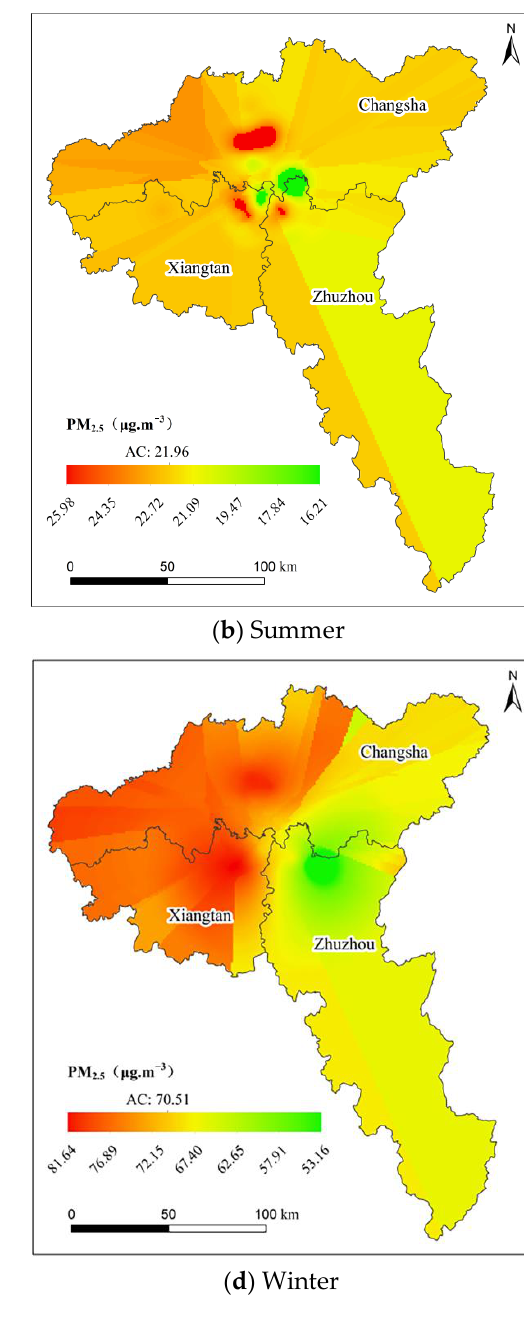
Figure 4. Inversion of seasonal PM 2.5 concentration in 2018 in the Chang Zhu Tan urban agglomeration. AC means average PM 2.5 concentration.